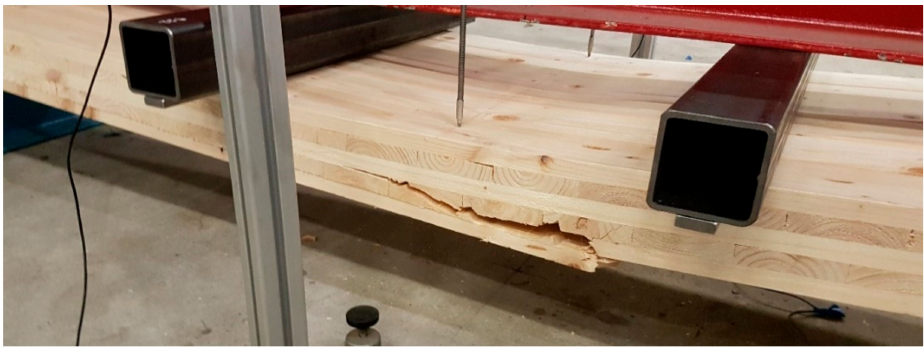
Figure 3. Bending failure on the bottom tensile face of the panel (B-5-20-7).